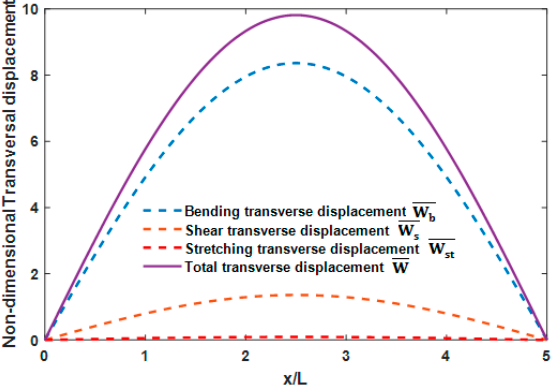
Figure 6. Shear and stretching effects on the transverse displacement.